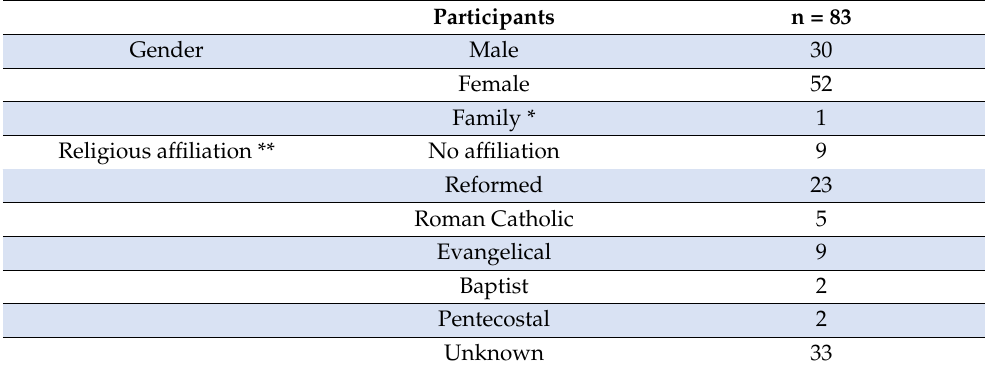
Table 2. Participant characteristics (demographic